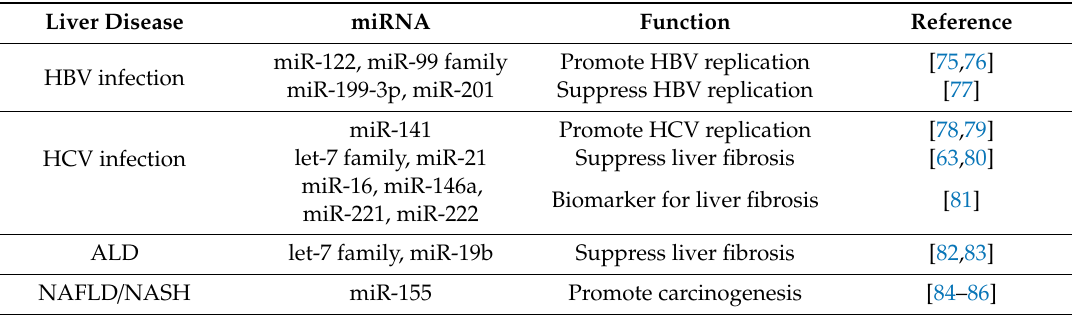
Table 1. microRNAs (miRNAs) associated liver